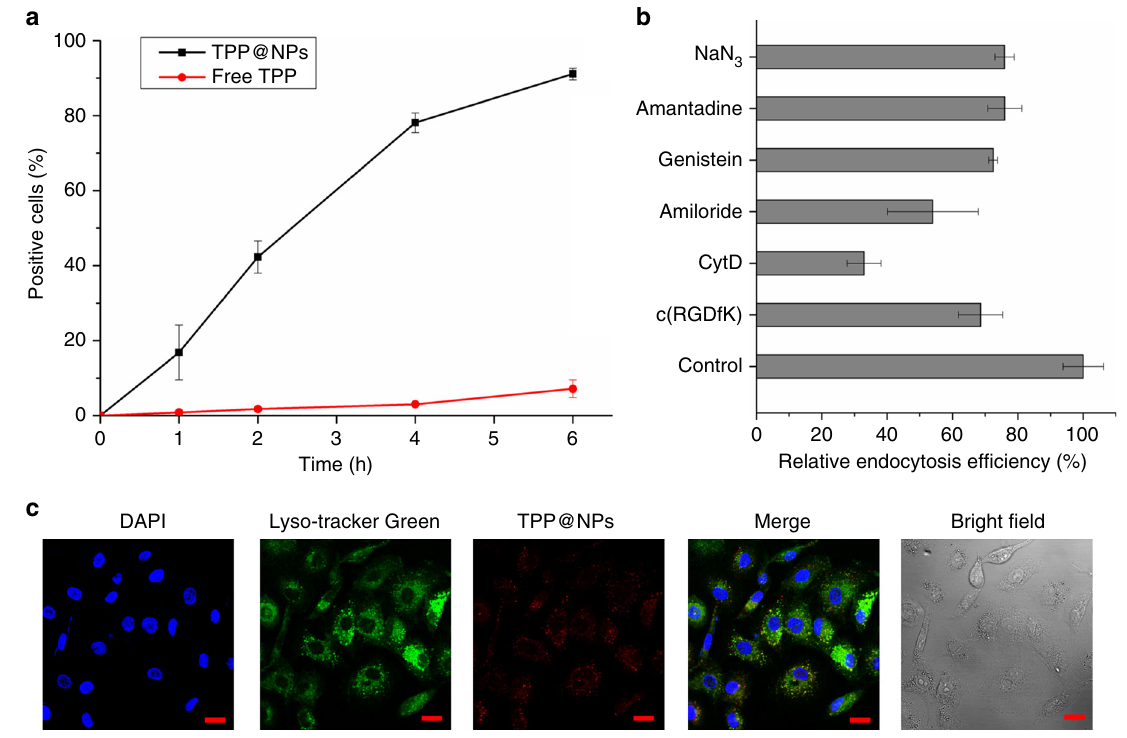
Fig. 4 Cellular uptake of TPP@NPs. a Time-dependent cellular uptake of free TPP (red line) and TPP@NPs (black line). b In fl uence of pharmacological inhibitors on cellular uptake of TPP@NPs by A549 cells. Concentration of inhibitors: amantadine HCl, 1.00 × 10 ‒ 3 mM; genistein, 100 mM; amiloride HCl, 2.00 mM, CytD, 10.0 μ g mL ‒ 1 ; c(RGDfK), 50.0 nM. c 2D CLSM images of A549 cells stained by TPP@NPs (red), Lyso-tracker Green (staining lysosomes, green) and DAPI (staining nucleus, blue). The scale bar was 20 μ m. Data are expressed as means ± s.d. ( n =